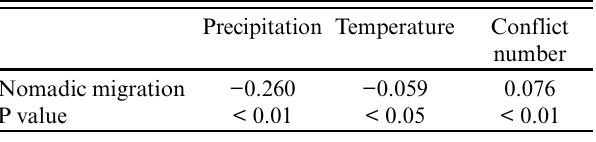
Table 1 . Correlation analysis of climate change, nomadic migration, and conflict